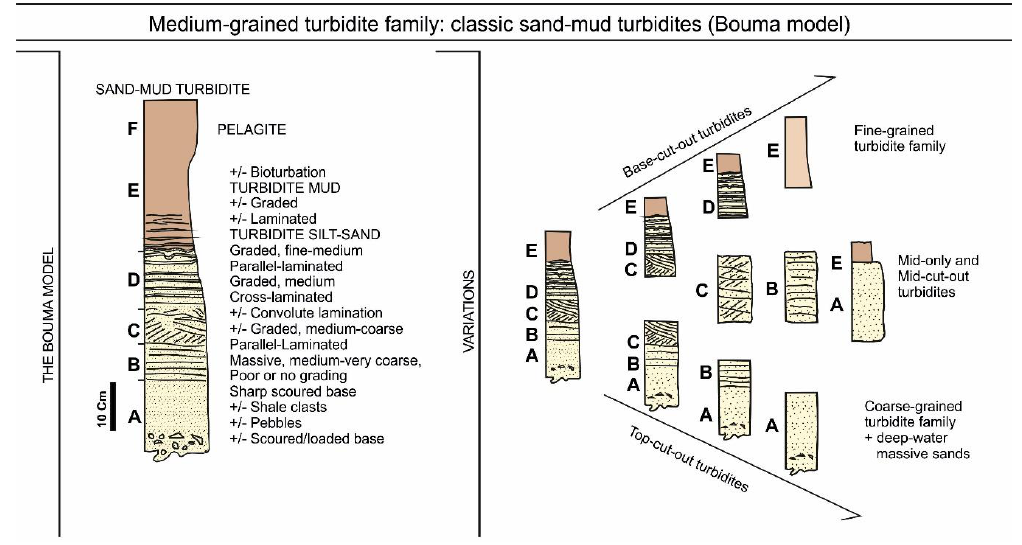
Figure 8. The medium-grained turbidite family for sand and sand–mud turbidites. The ideal Bouma